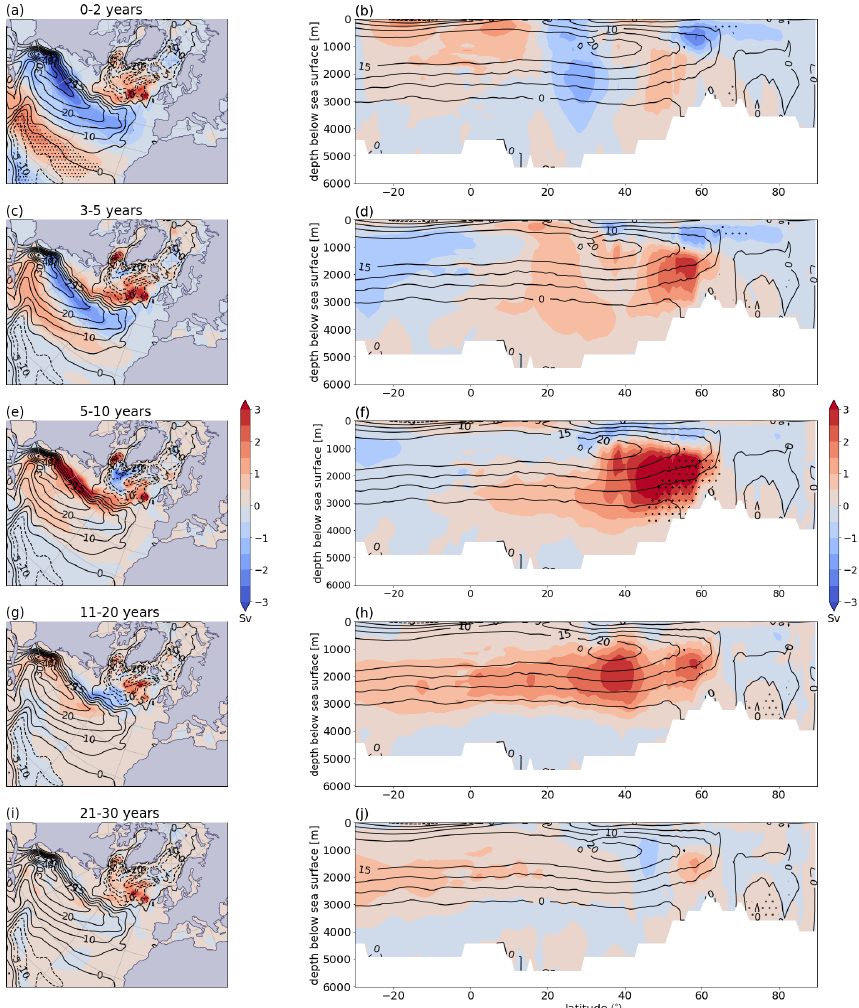
Figure 5. Maps of barotropic stream function (BTS) and Atlantic meridional overturning circulation (AMOC) ensemble mean anomalies for 2 years (a, b) , 3–5 years (c, d) , 6–10 years (e, f) , 11–20 years (g, h) , and 21–30 years (i, j) after the four large eruptions. 1–1850CE climatology is in contours. For the BTS anomaly (left panels), negative absolute values indicate anticlockwise rotation and positive absolute values indicate clockwise rotation. For AMOC (right panels), negative anomalies correspond to a decrease in streamflow, and positive anomalies correspond to an increase in streamflow. Anomalies are with respect to the 1–1850CE background climatology. 2 σ significant areas are